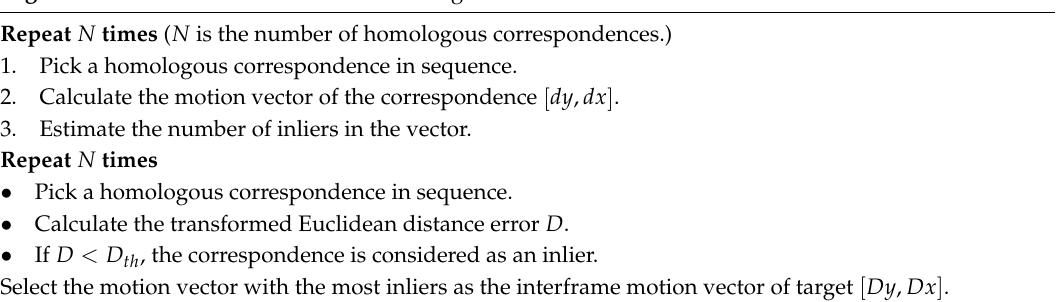
Algorithm 1. Interframe Motion Vector of Target